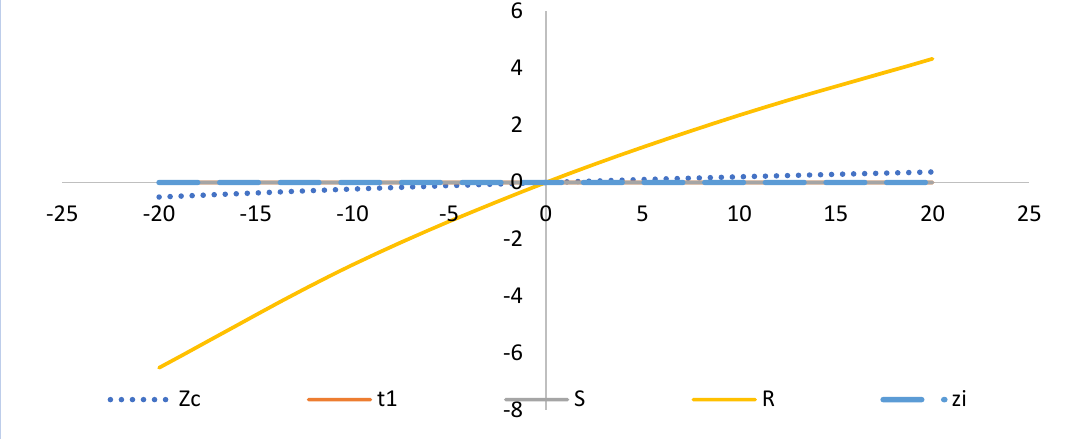
Figure 10. Impact of post optimality analysis of ‘ e 1 ’ on Z C , t 1 , S , R , and ξ